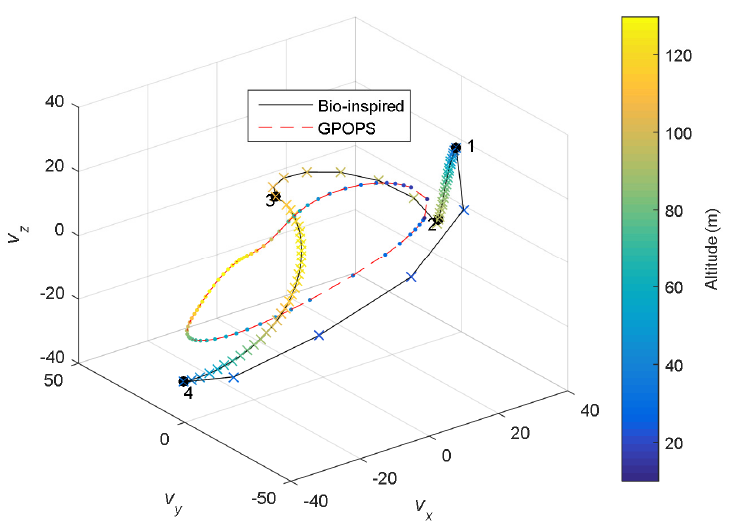
Figure 18. Phase portraits of the Rayleigh cycles of the GPOPS and proposed bio ‐ inspired methods in the velocity space (1–2: upwind climb, 2–3: high ‐ altitude turn, 3–4: downwind dive, and 4–1: low ‐ altitude turn.